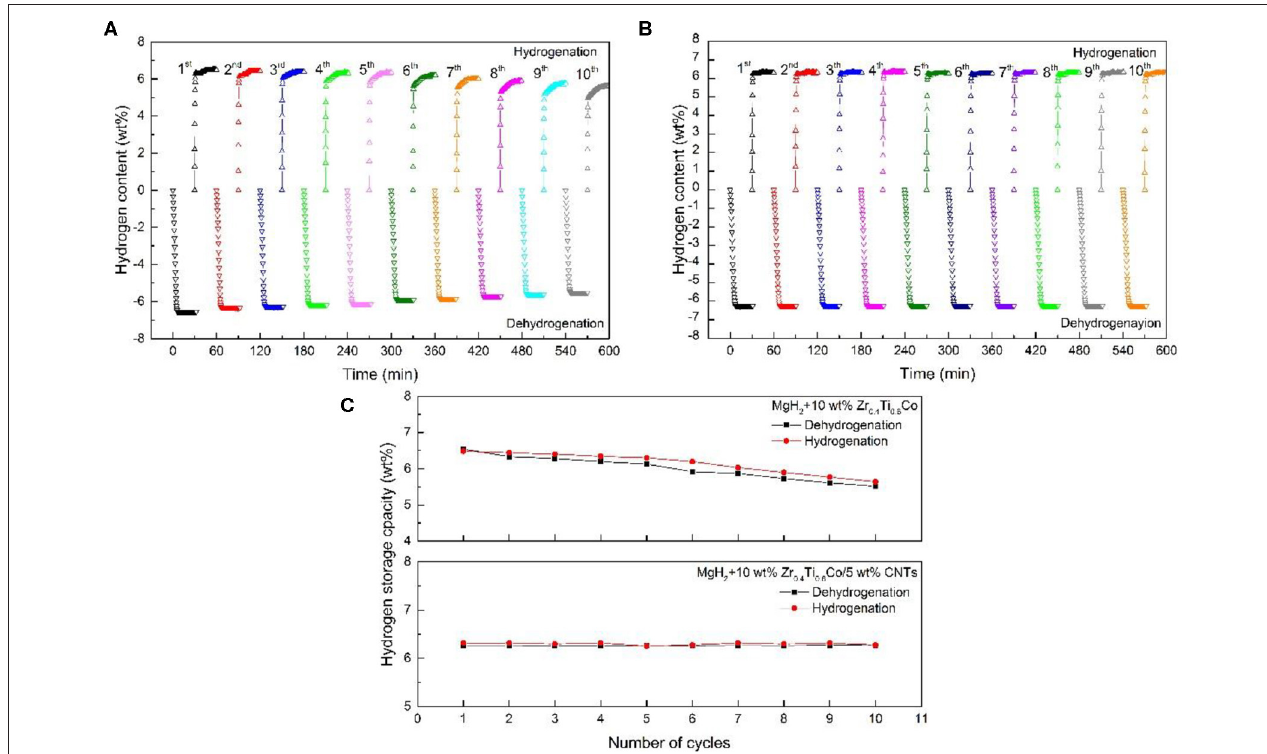
FIGURE 6 | Non-isothermal dehydrogenation/hydrogenation curves of the MgH 2 + 10 wt% Zr 0.4 Ti 0.6 Co (A) , MgH 2 + 10 wt% Zr 0.4 Ti 0.6 Co/5 wt% CNTs (B) composites and as a function of cycling and the resulting line chart (C) . Reproduced from Zhang L. et al. (2020) with permission from